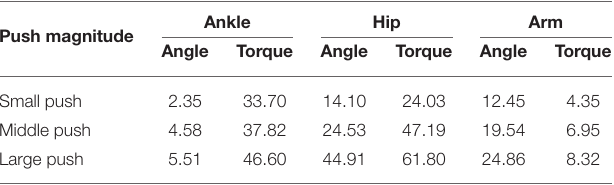
TABLE 4 | Mean of the peak-to-peak value of the joint angles (Unit: [ degree ]) and torques (Unit: [ Nm ]) of the ankle, hip, and arm for different pushing forces. Ankle Hip Arm Push magnitude Angle Torque Angle Torque Angle Torque Small push 2.35 33.70 14.10 24.03 12.45 Middle push Large